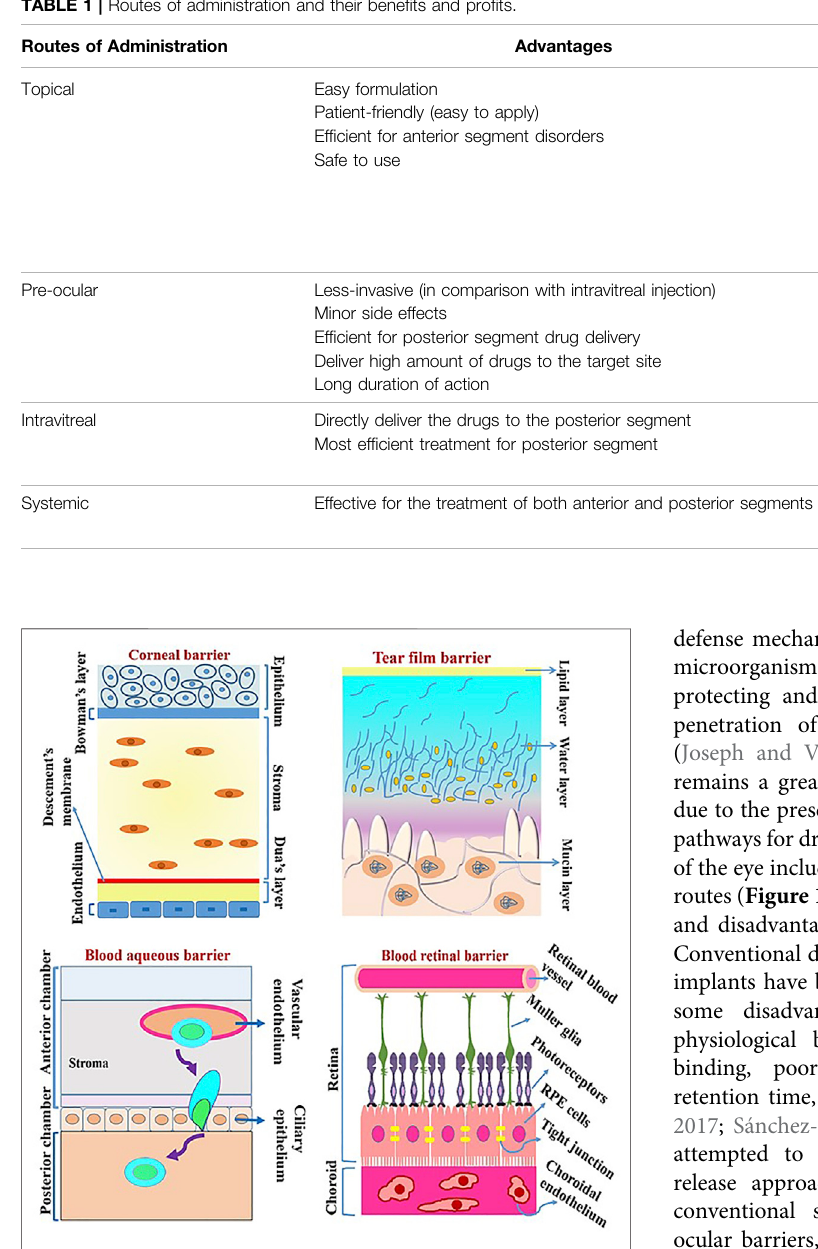
FIGURE 3 | Various barriers in the eye which drugs must overcome to reach the target sites.